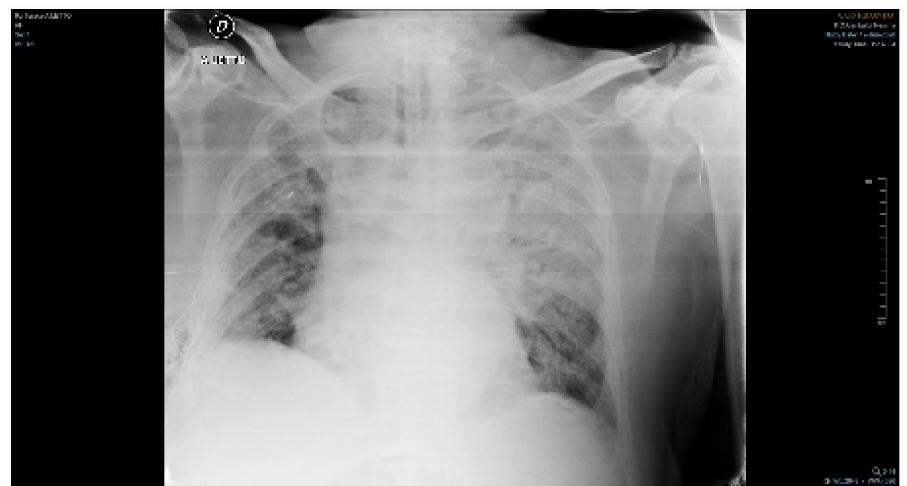
Figure 1. Chest radiograph shows several non-specific findings such as diffuse opacities, which correlate with clinical evidence of respiratory